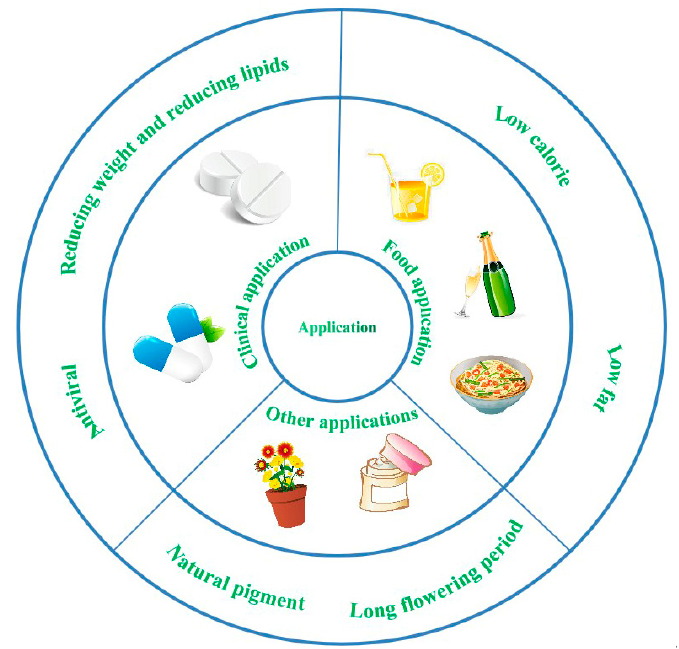
Figure 7. The application of P. grandiflorus.